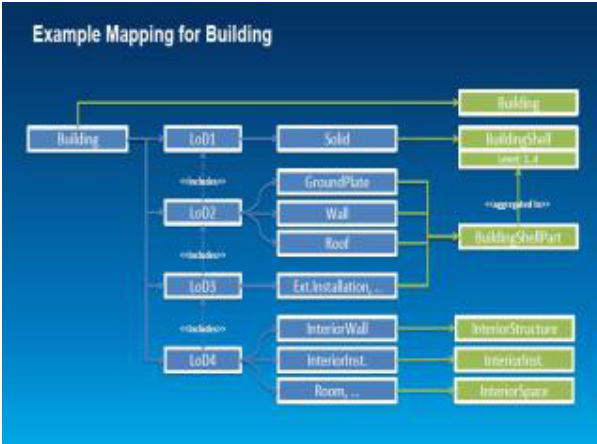
Figure 1 8: The structure of the 3DCIM (Arcgis.com,